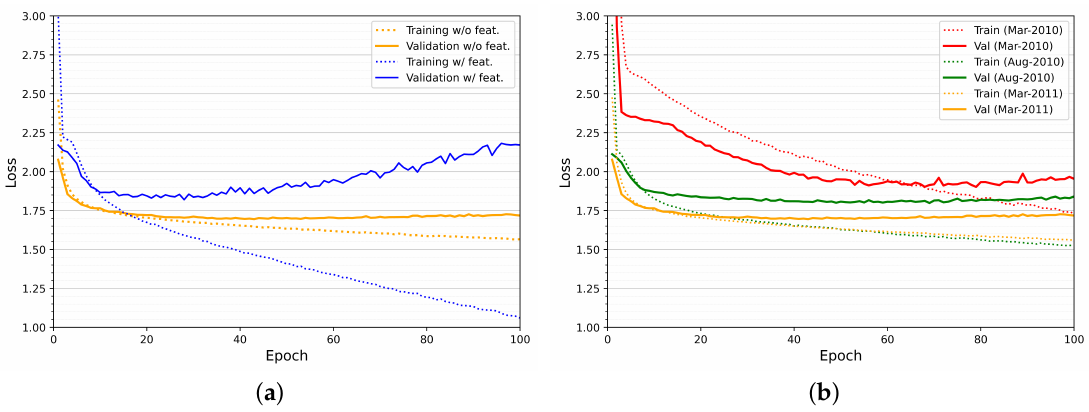
Figure 5. Cross-entropy loss for B09 user including and not including the features ( a ) and cross-entropy loss for B09 in different months not including the features ( b